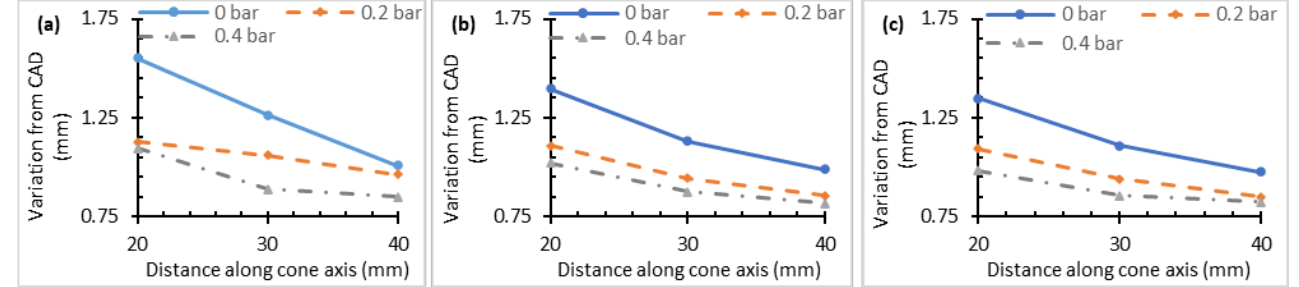
Figure 16. Variation from CAD at end of process as predicted by simulation using ( a ) GTN material model, ( b ) FFLD model, and ( c ) DD model for different pressure settings. Table 4. Summary of findings. Table 3. Comparison of experimental and numerical results of various material models at different pressure settings.